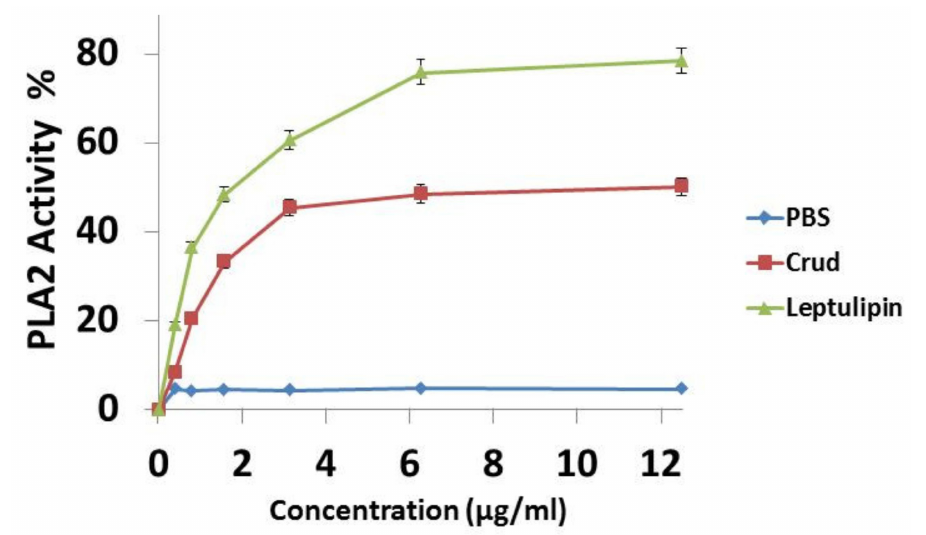
Figure 8. Evaluation of PLA2 activity. Various concentrations of leptulipin and crude venom were incubated with reaction mixture containing 3.5 mM lecithin. The PLA2 activity percentage was calculated from the phenol red absorbance variations due to the fatty acid release. PBS was used as a negative control. Leptulipin reached its maximum activity at ca. 6.25 µ g/mL (N =